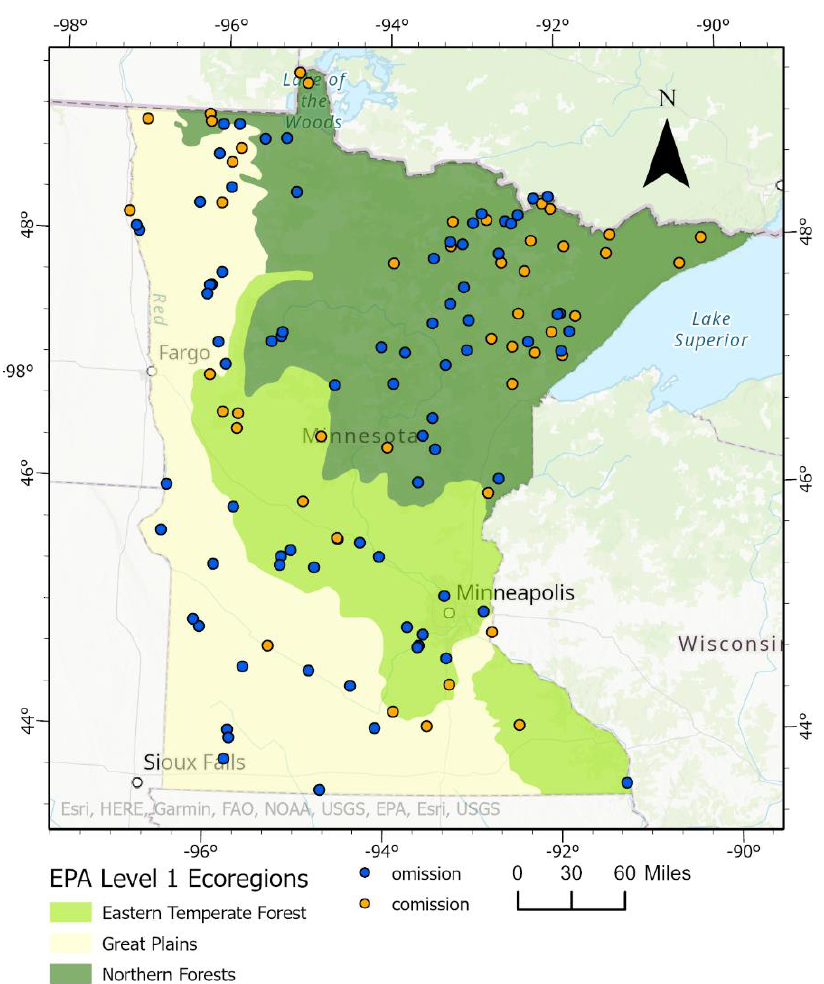
Figure 5. The spatial distribution of accuracy assessment errors. The Northern Forests and Eastern Temperate Forest ecoregions have similar amounts of omission and commission points, with similar accuracies to the overall accuracy. The Great Plains ecoregion has a disproportionately high number of omission points, leading to a significantly lower producer’s accuracy for this